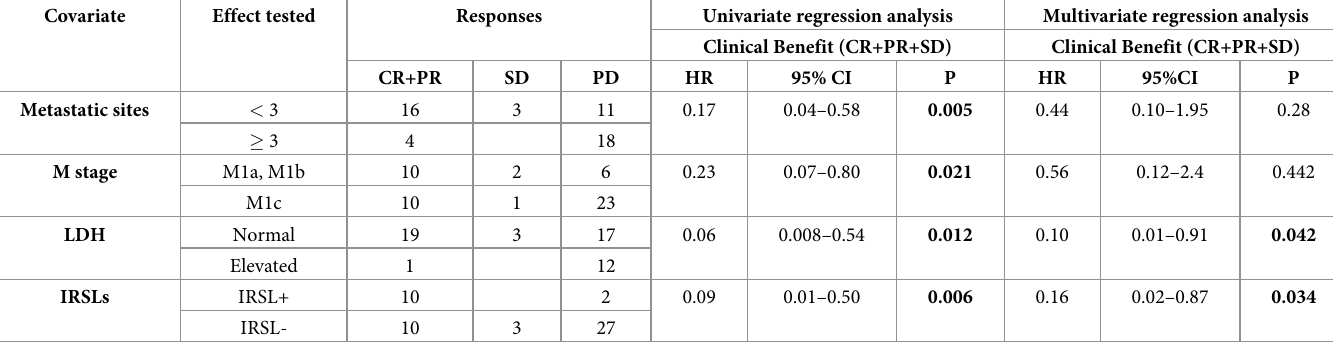
Table 3. Univariate and multivariate regression analysis of factors associated to response to target therapy.